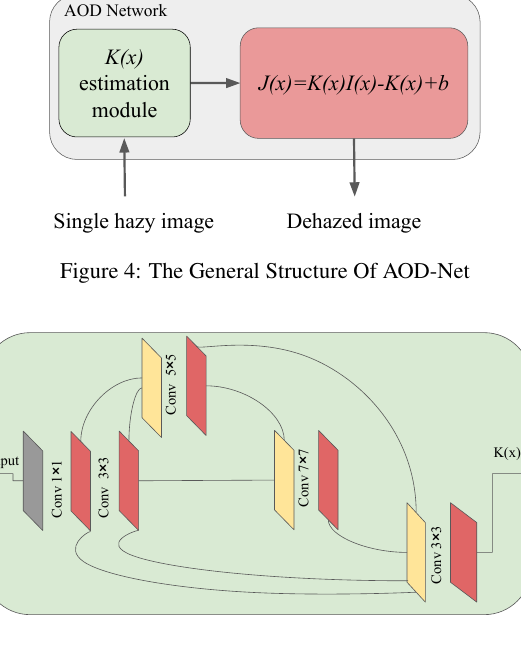
Figure 5: The K ( x ) estimation